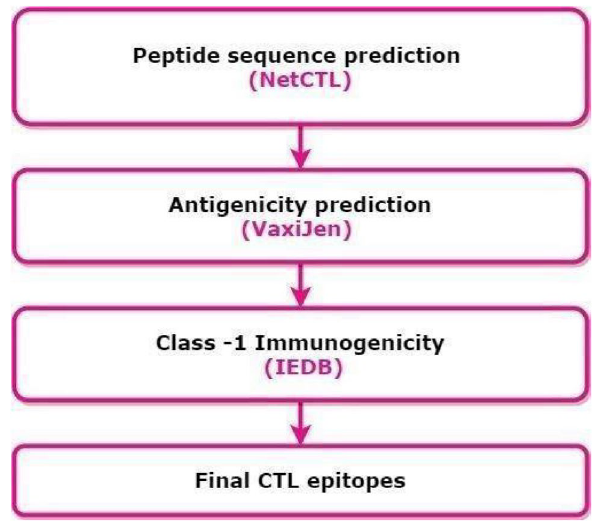
Figure 4. Workflow for selecting cytotoxic-T-lymphocyte epitope sequences (Draw.io—https:// www. diagr ams. net/- 14.6. 10).